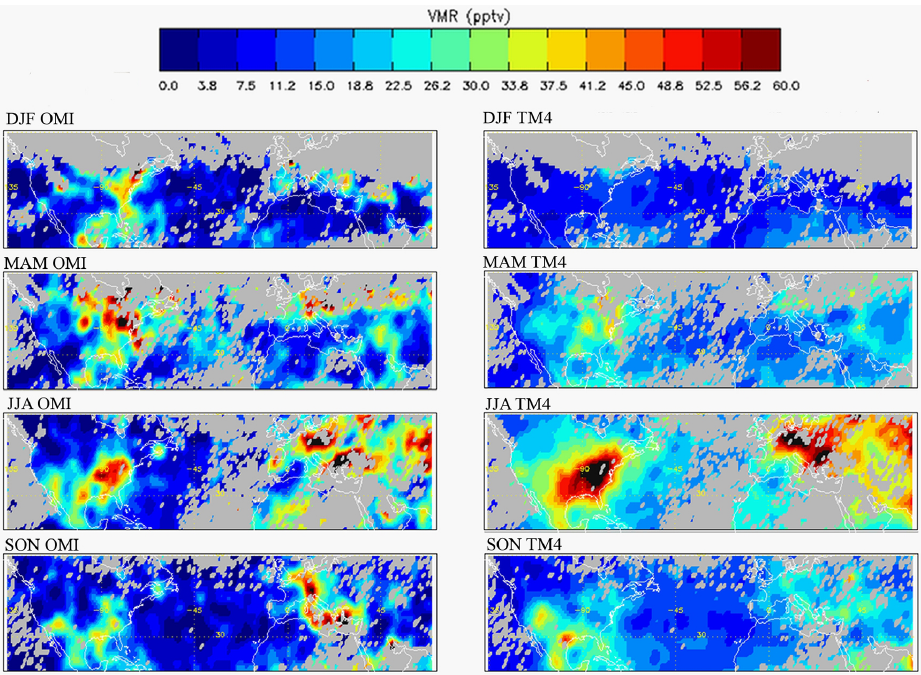
Figure 29. North American and European sectors at 380hPa: seasonal variability in OMI (left column) versus TM4 model (right column) average NO 2 VMR pseudoprofiles for the year 2006.